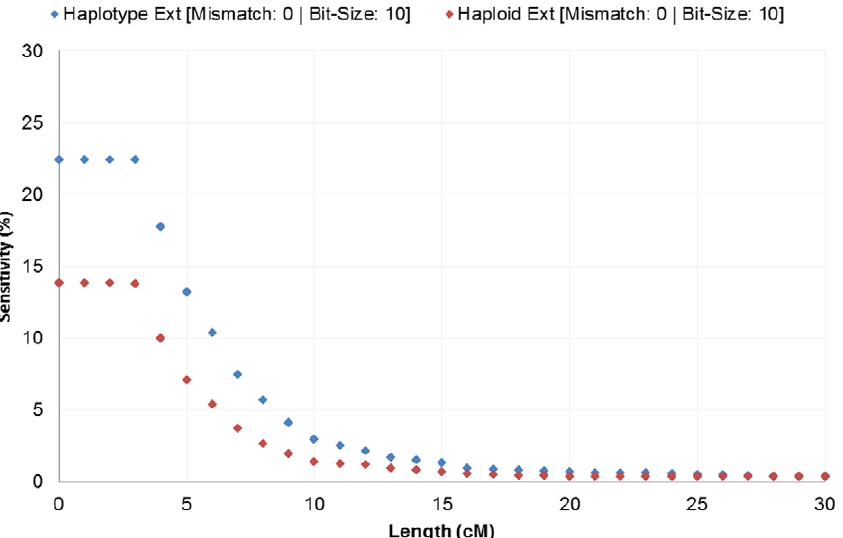
Figure 2. Exome sensitivity with varying segment length. Exome sequencing IBD data is shown to have low sensitivity with GWAS IBD data. The sensitivity decreases as the threshold increases for allowed segment